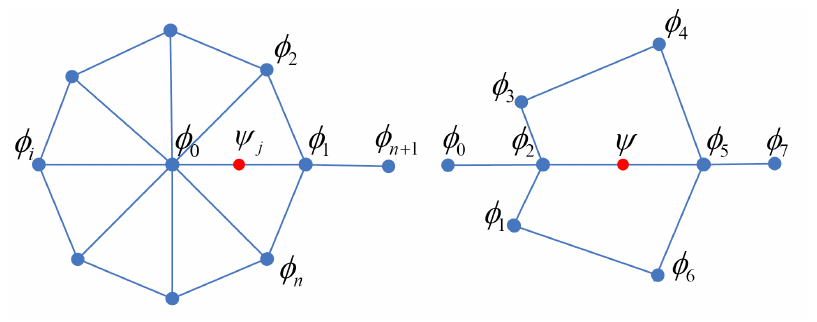
Figure 4. Constructing wavelets as linear combination of lazy wavelets and scaling functions in radial layers.